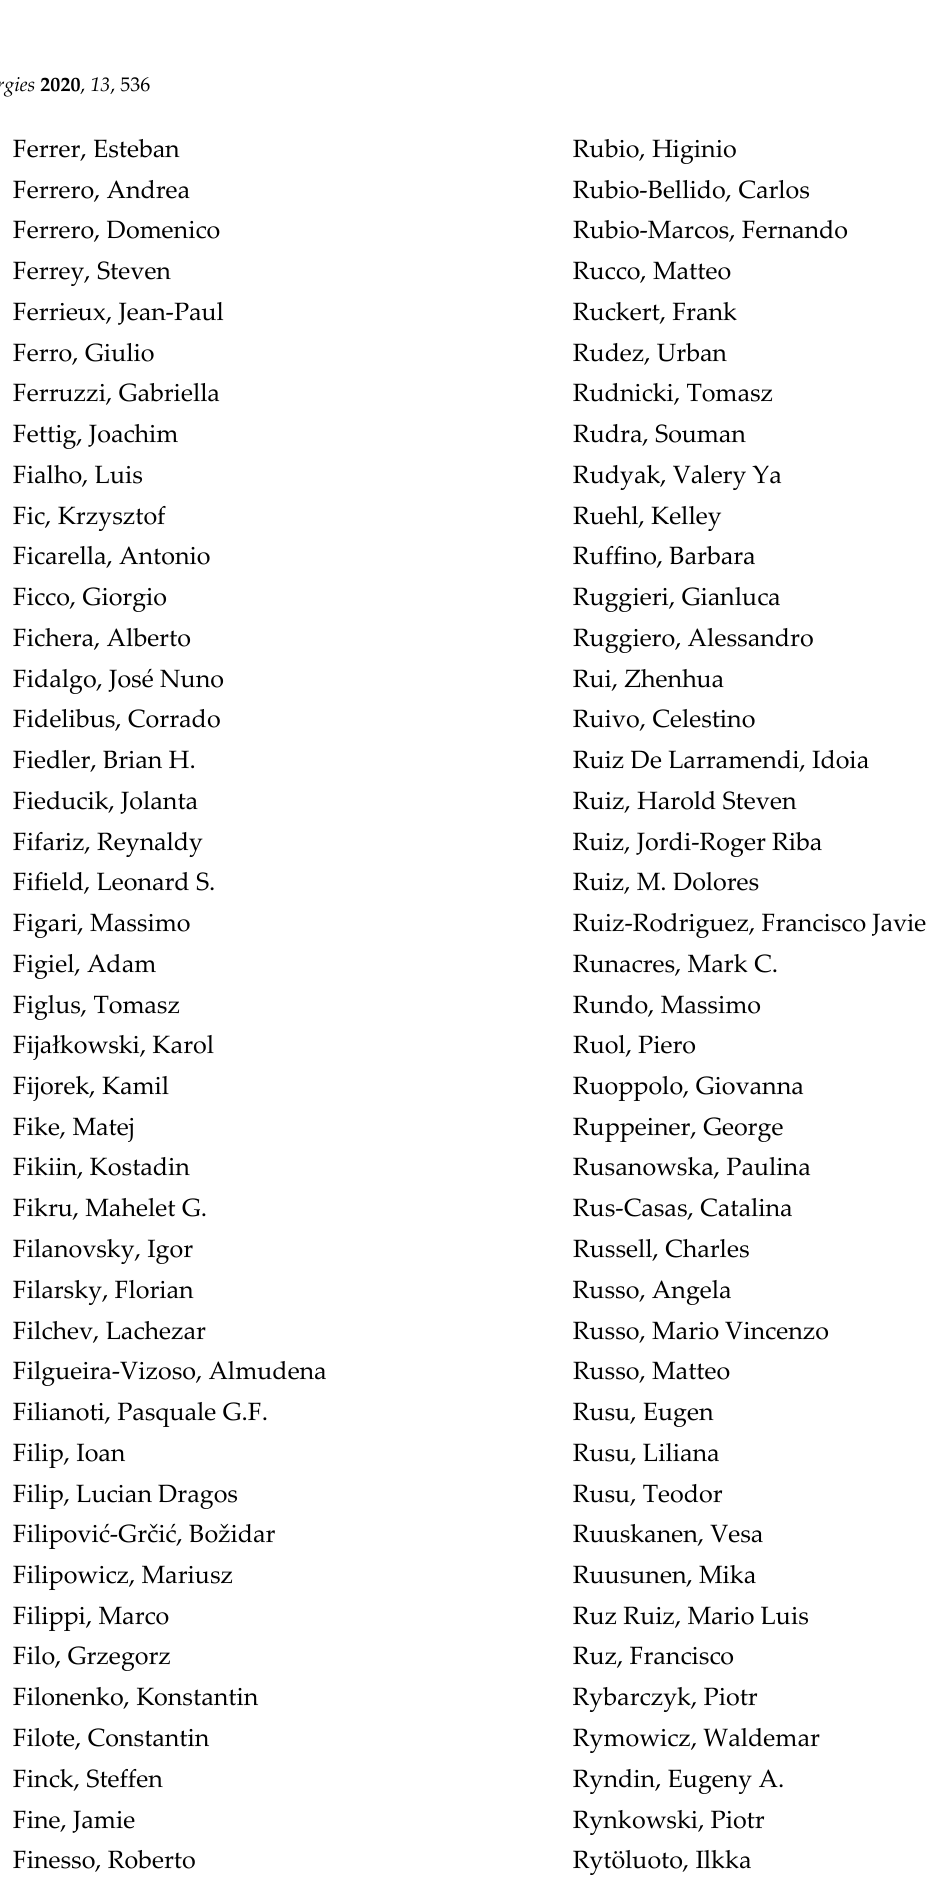
Figiel, Adam Figlus,